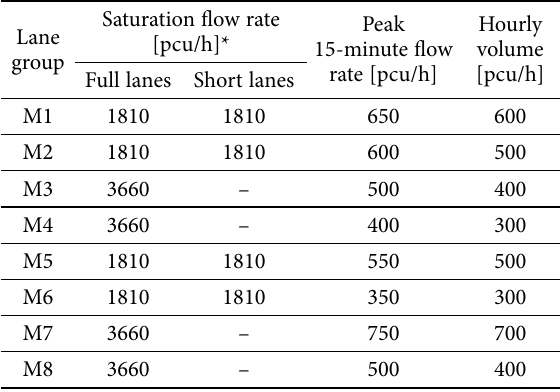
Table 1. Saturation flow rates, peak 15-minute flow rates and hourly